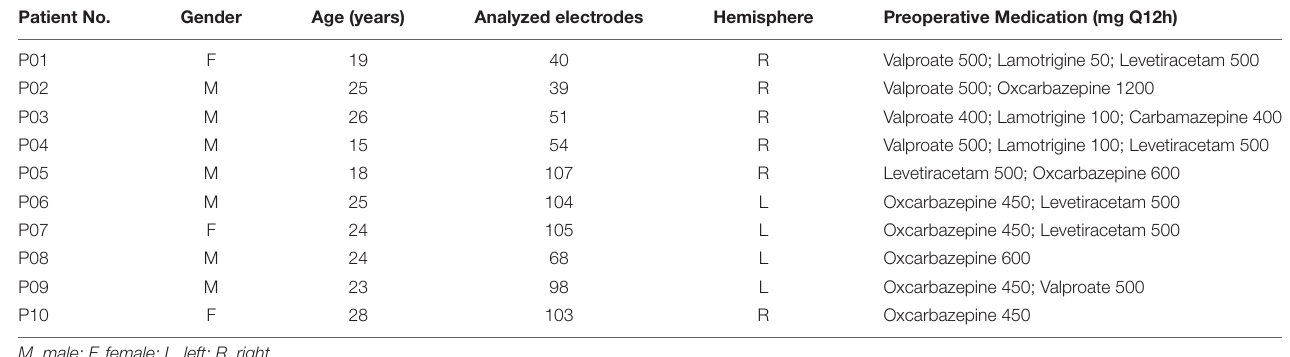
TABLE 1 | Clinical and demographic characteristics of the patient participants. Patient No.